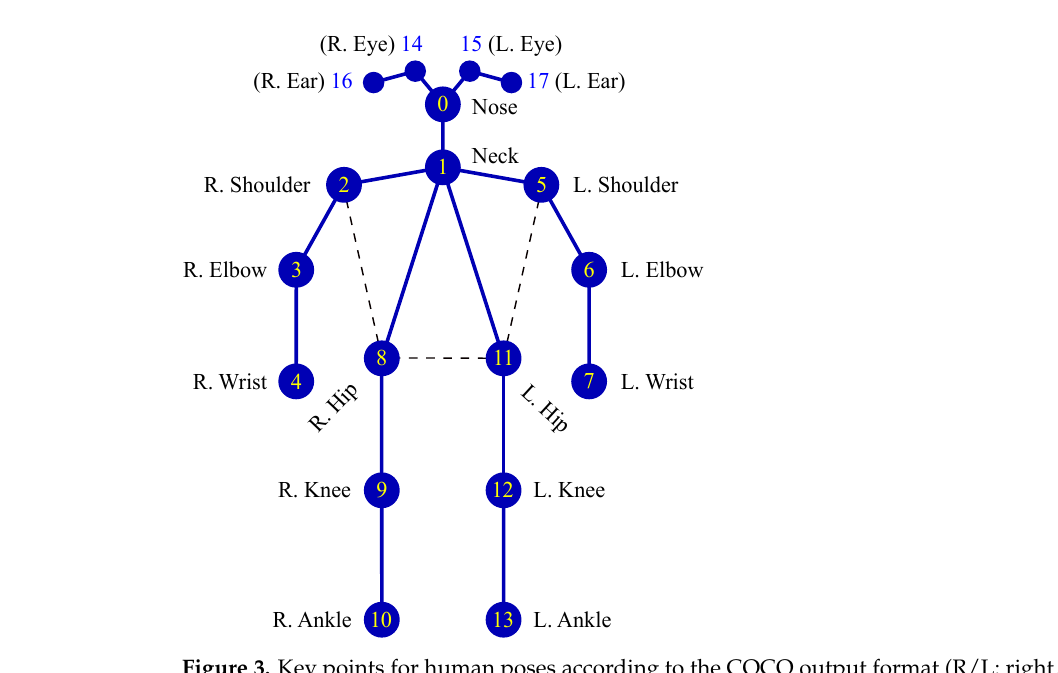
Figure 3. Key points for human poses according to the COCO output format (R/L: